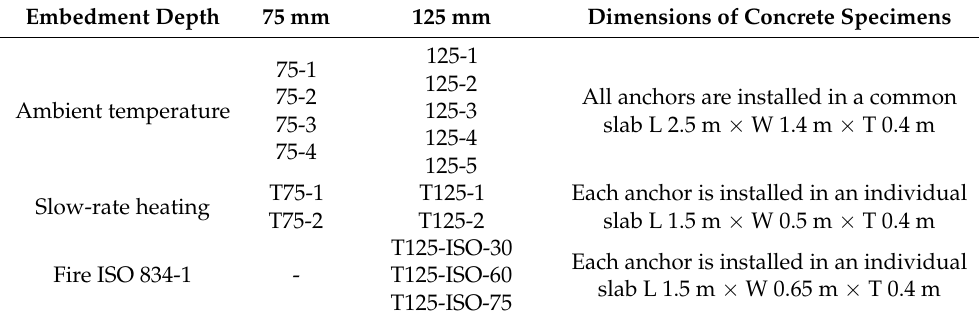
Table 1. Matrix of the test